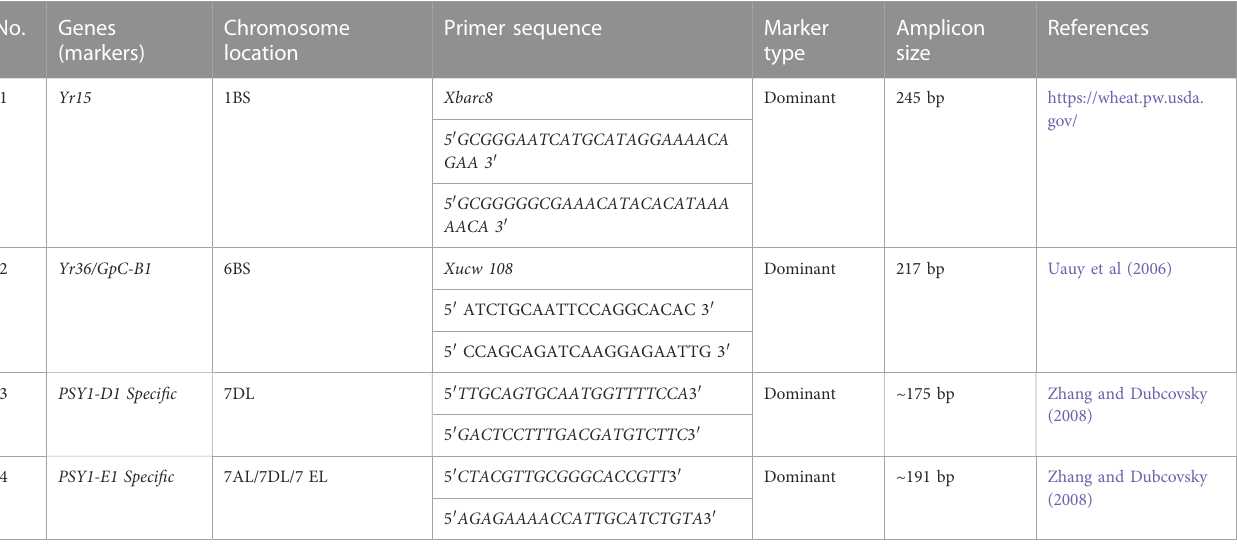
speci fi c PCR (polymerase chain reaction) pro fi les